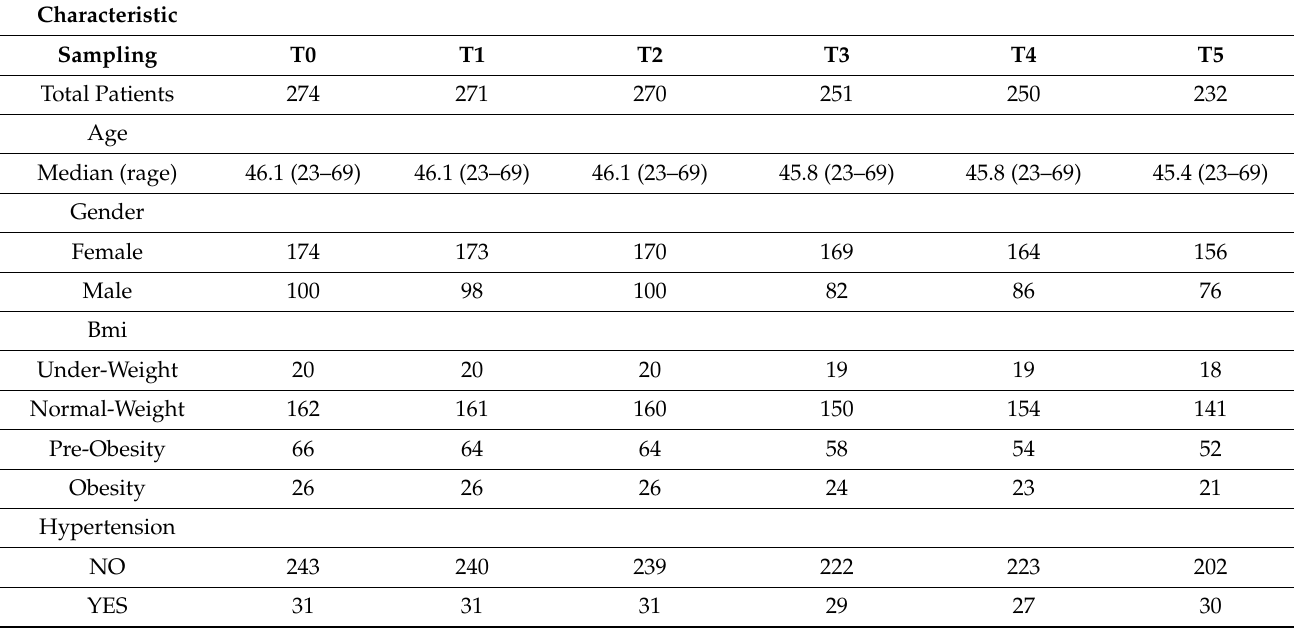
Table 1. Demographic and clinical characteristics of the